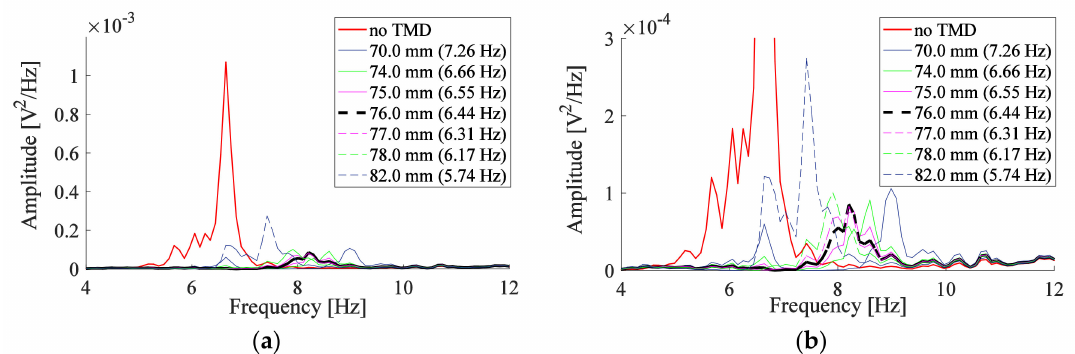
Figure 6. Responses measured by vibrometer for the system with one TMD for ( a ) screw at different positions along the beam; ( b ) same as ( a ) but with different y -axis limit.